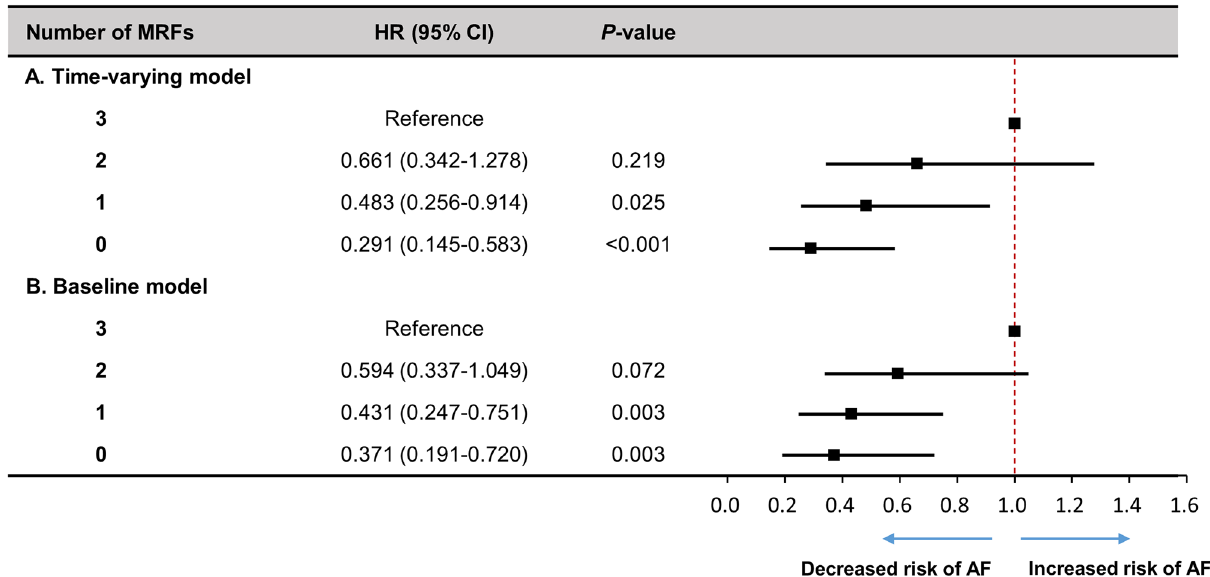
Figure 1. Modifiable risk factors and AF risk in general population using baseline and time-updated models. Modifiable risk factors include time-updated systolic blood pressure ≥ 140 mmHg, obesity with central obesity, and inactivity. Hazard ratios (HR) for the baseline model were adjusted for age, sex, area, chronic kidney disease, cardiovascular disease, HbA1c and total cholesterol at baseline. Time-updated models were adjusted for sex and area at baseline, and time-updated assessment of age, chronic kidney disease, cardiovascular disease, HbA1c and total cholesterol. MRFs = modifiable risk factors; HR = hazard ratio; AF = atrial fibrillation.